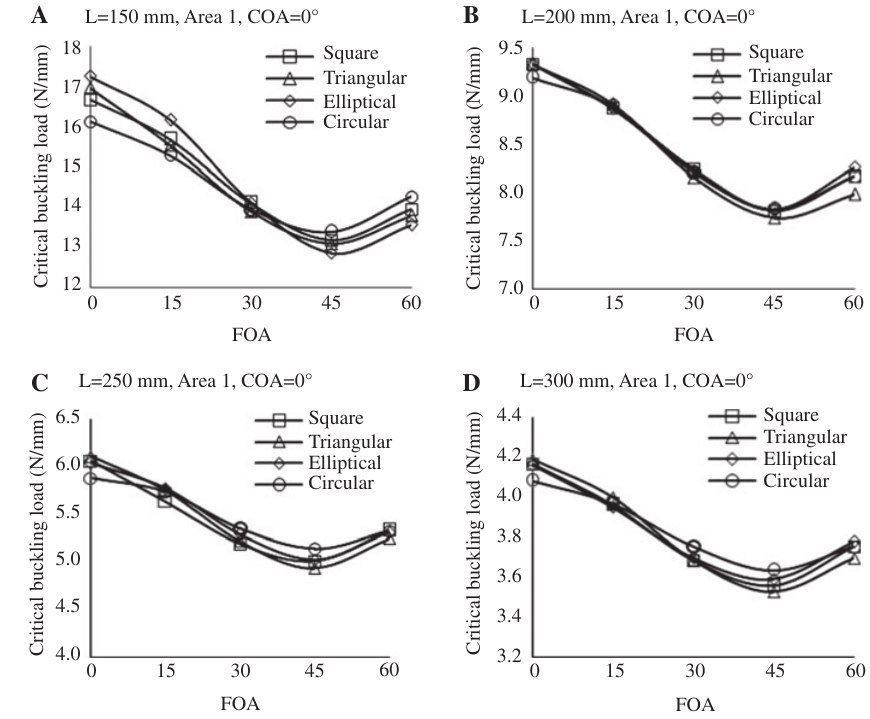
Figure 7 The effects of FOA on buckling load of the composite plates for L (A) 150 mm, (B) 200 mm, (C) 250 mm and (D) 300